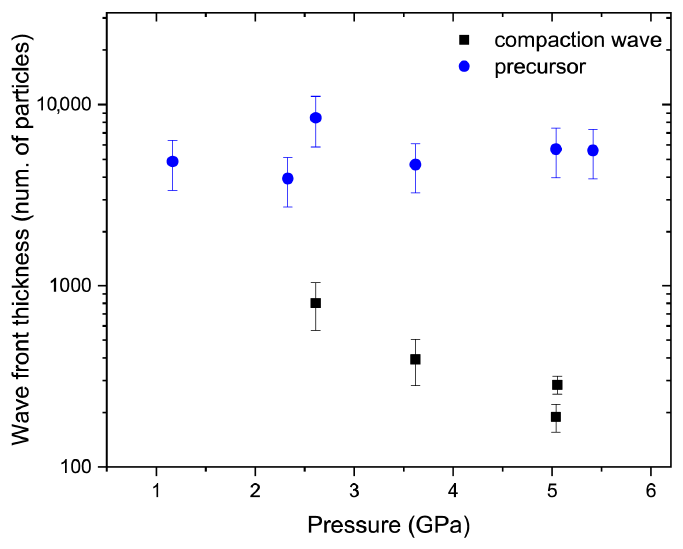
Figure 13. Wave front thickness versus the pressure data for both waves.